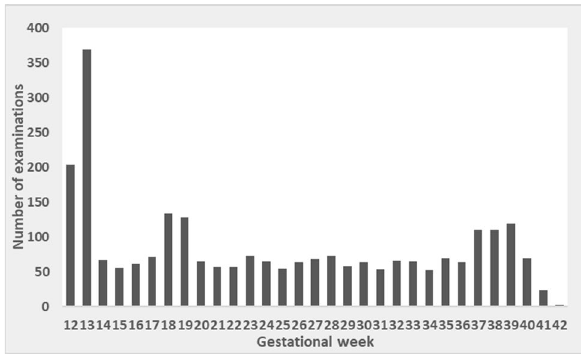
Figure 1. Distribution of ultrasound examinations by gestational